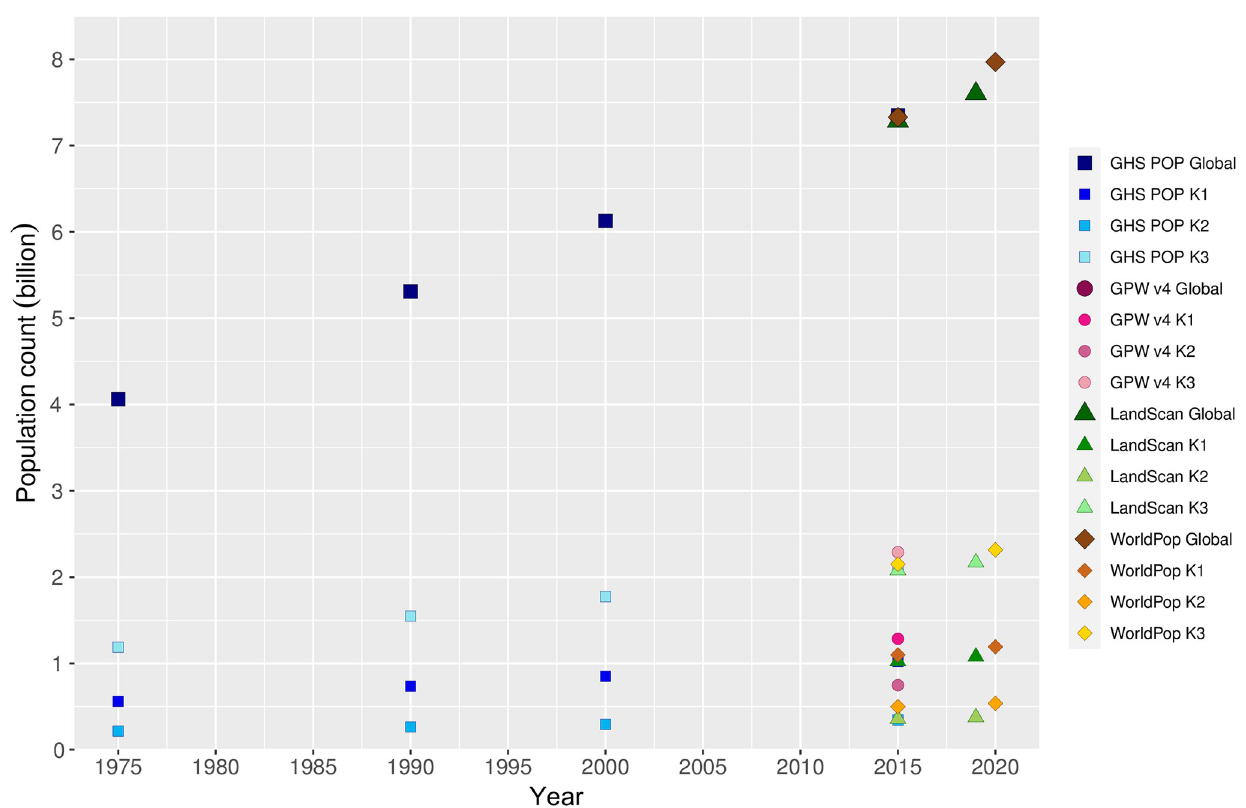
Fig 1. Global total (circles) and mountain-only (triangles) population over recent decades according to all input population and mountain delineation datasets combinations. Note that some of the data points for the 2015 estimates are partially obscured by the others. The data plotted are presented in S7 Table in S1